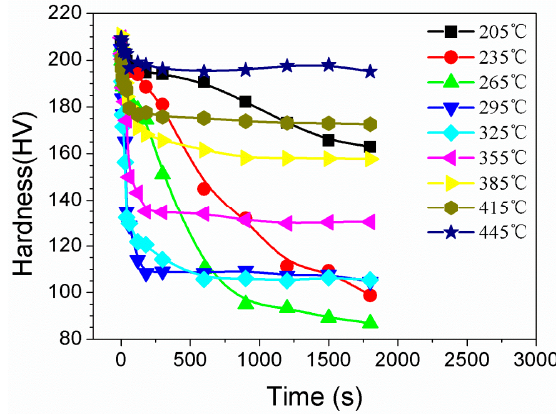
Figure 9. Hardness variation via the isothermal treated time on the studied samples having been solution treated at 470 °C for 1 h, isothermal heat treated for various durations, and then aged at 120 °C for 24 h.